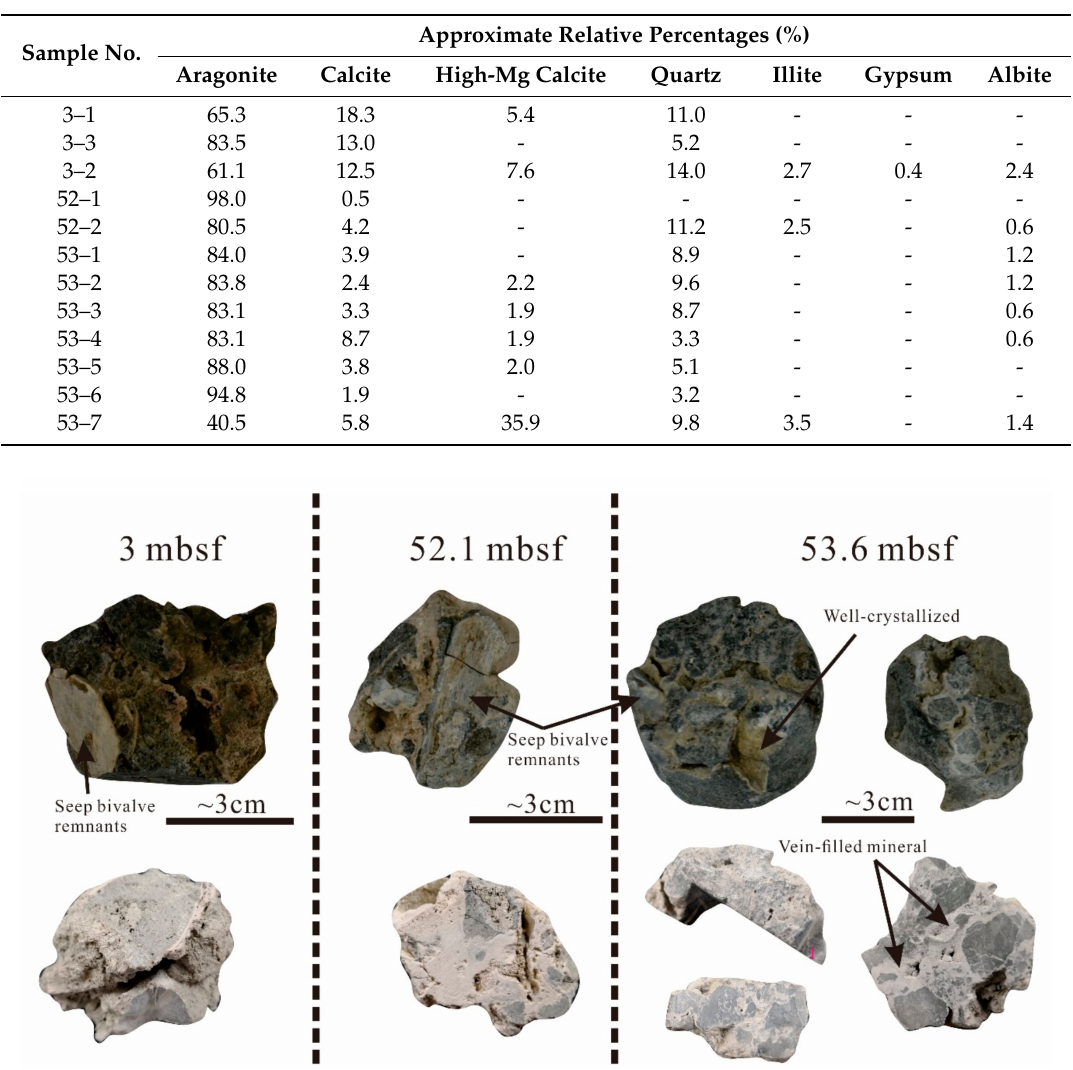
Figure 2. Carbonate samples recovered from core W08B. Color di ff erences resulted from di ff erent dryness. Above: Photographs of carbonate after recovery [30]. Below: Photographs of carbonate in the onshore laboratory prepared for